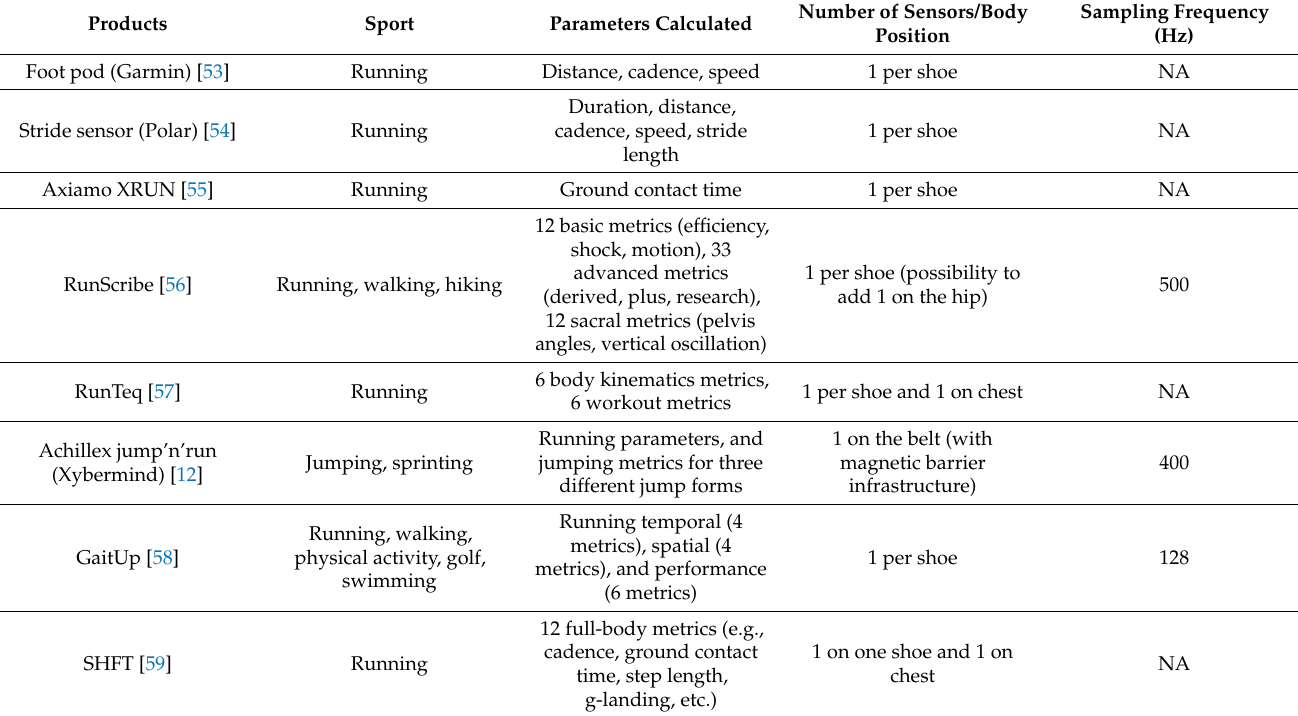
Table 4. Competitive